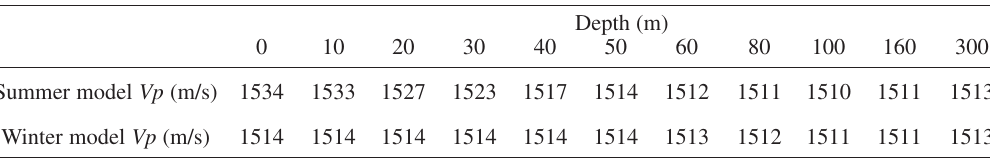
Table II. Sound velocities of the summer and winter models for increasing depths. The main differences be- tween the two models are above 50 m depth.